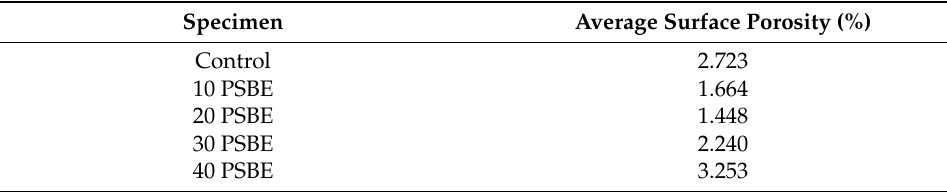
Table 7. Average surface porosity of PSBE